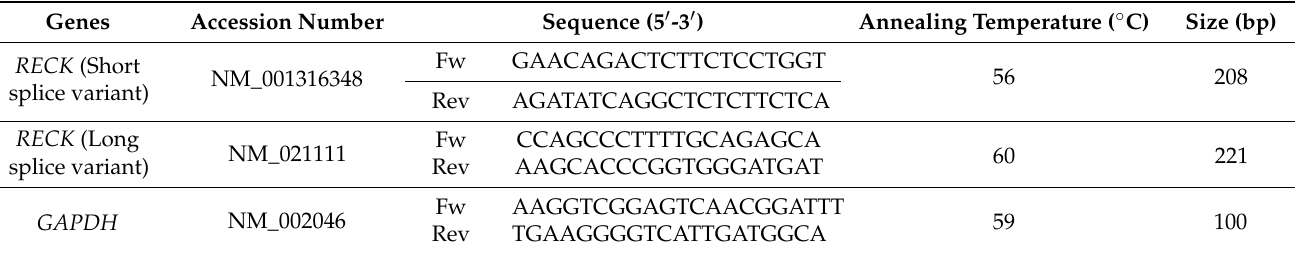
Table 1. Real-Time PCR primer sequences and amplification